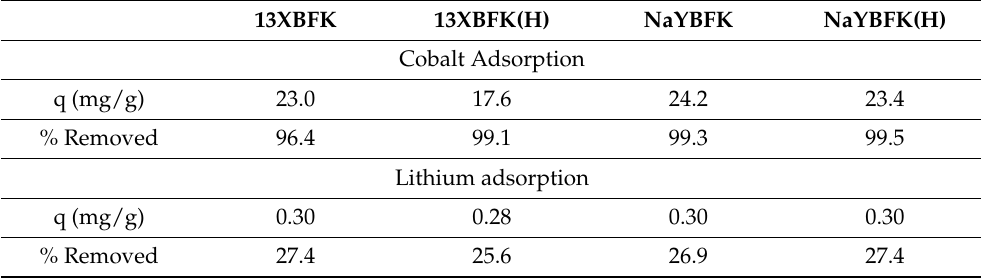
Table 3. Adsorption capacities and percentage of metal removed of 13XBFK, 13XBFK(H), NaYBFK and